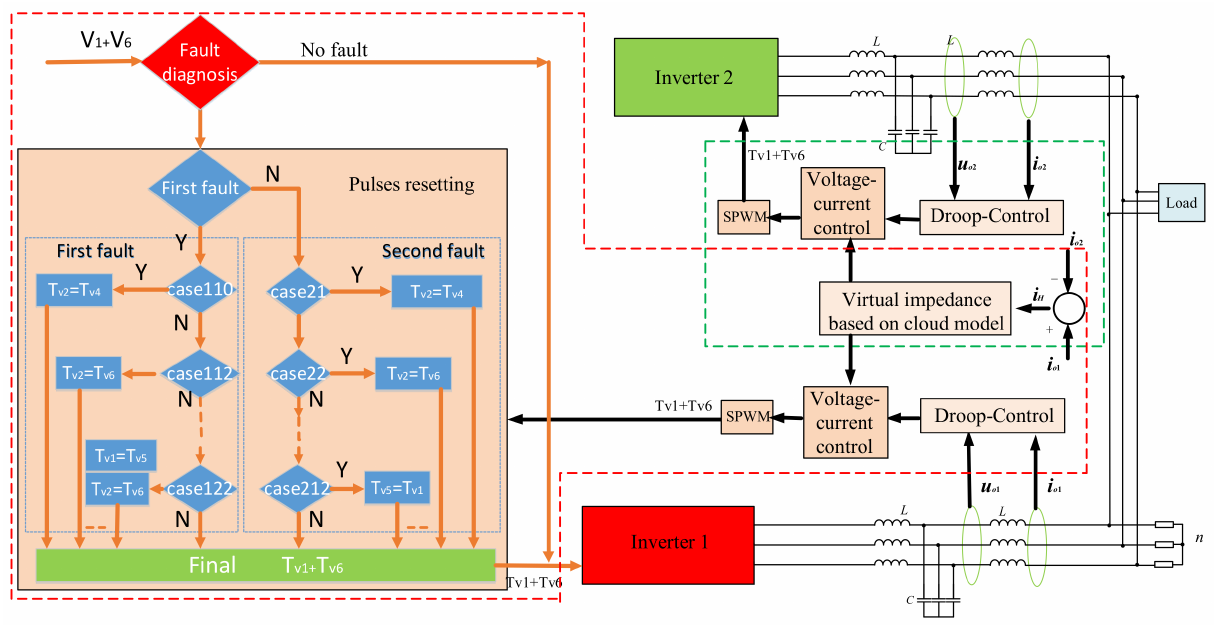
Figure 7. The general control strategy. The control schematic of the reconfigurable inverter 1 in off-grid microgrid is shown in the red dashed box. When inverter 1 is diagnosed without fault and it runs in normal state, inverter 1 only uses the control strategy connecting droop-voltage-current